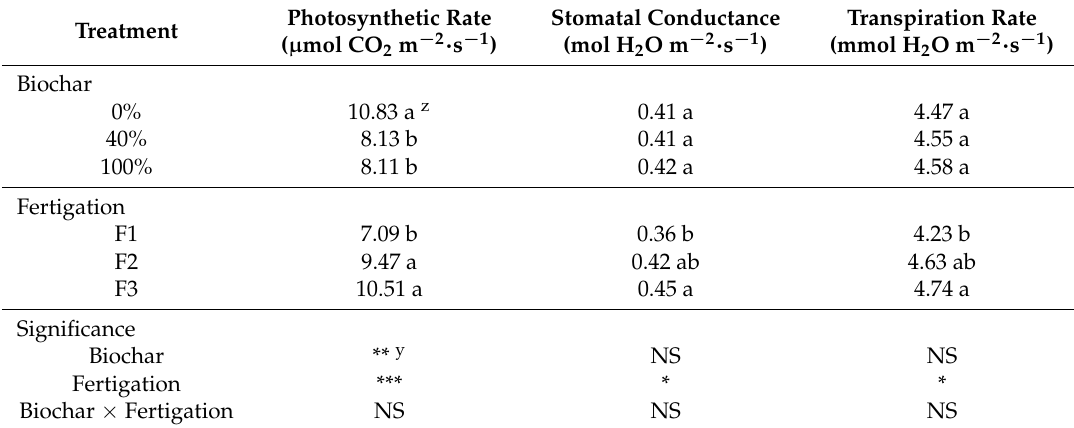
Table 4. Leaf gas exchange (photosynthetic rate, stomatal conductance to H 2 O, transpiration rate) of ‘Prestige Red’ poinsettia nine weeks after transplanting in root substrate amended with 0%, 40%, and 100% biochar and fertigated with fertigation regimes 1, 2, and